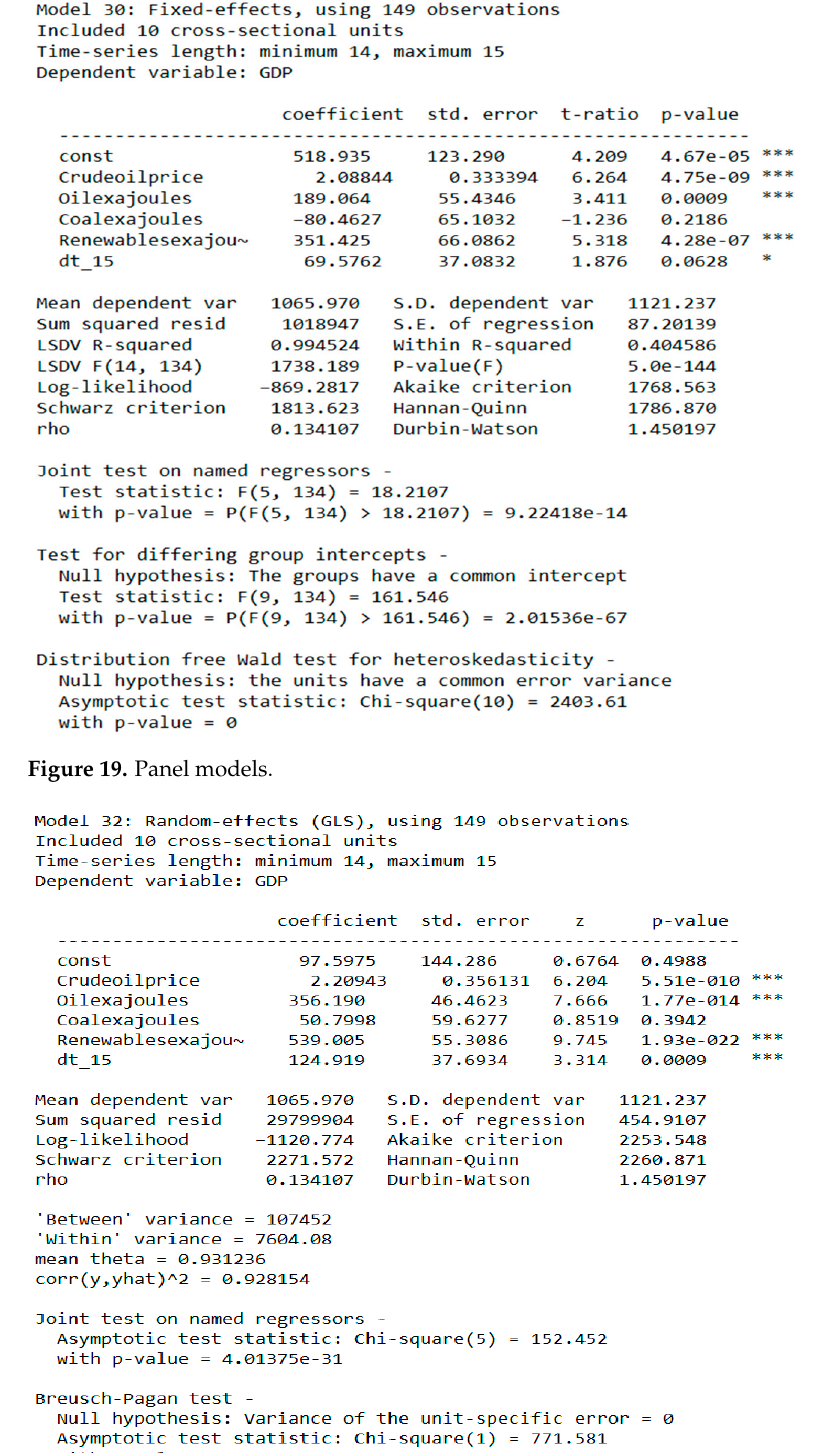
Figure 20. Joint test on named regressors.